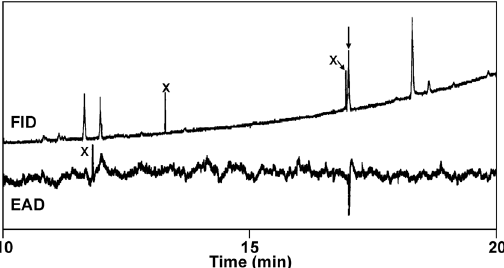
Figure 3. Analysis by coupled gas chromatography-electroantennogram detection of an extract of headspace volatiles produced by male Aromia bungii . Top trace shows the GC detector response; bottom, inverted trace shows the corresponding response from the antenna of a female A. bungii . Peaks marked with an X are artefacts.